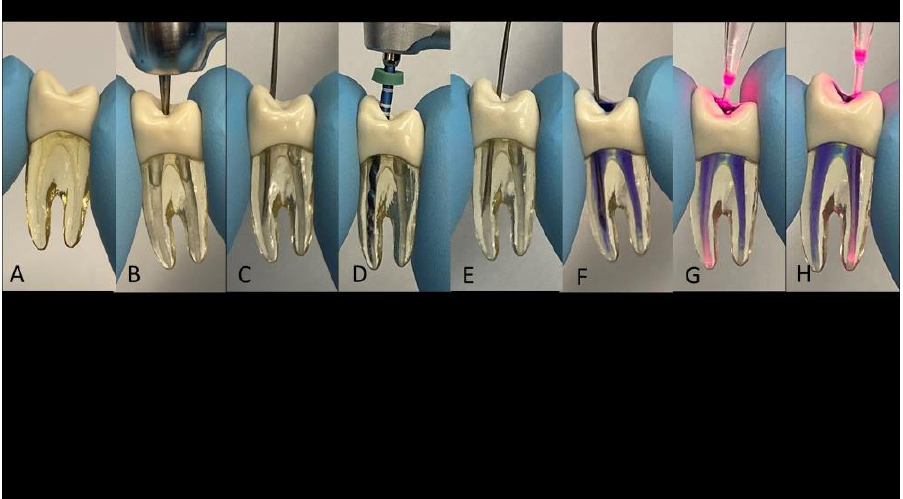
Figure 4. Schematic sequence of the antimicrobial photodynamic therapy clinical protocol applies for root canal disinfection. ( A ) Pre-treatment tooth diagnosis with infected canals. ( B ) Access to root canal system to remove the infective pulpal tissues. ( C ) Chemical debridement and irrigation with 2.5% of sodium hypochlorite (NaOCl). ( D ) Mechanical instrumentation using rotary files to remove the infective radicular dentine. ( E ) A final rinse with 0.9% of saline. ( F ) A photosensitizer applied inside the canal for 1 min. ( G , H ) A red light-emitting diode (LED; 660 nm; 200 mW), used to activate the photosensitizer.